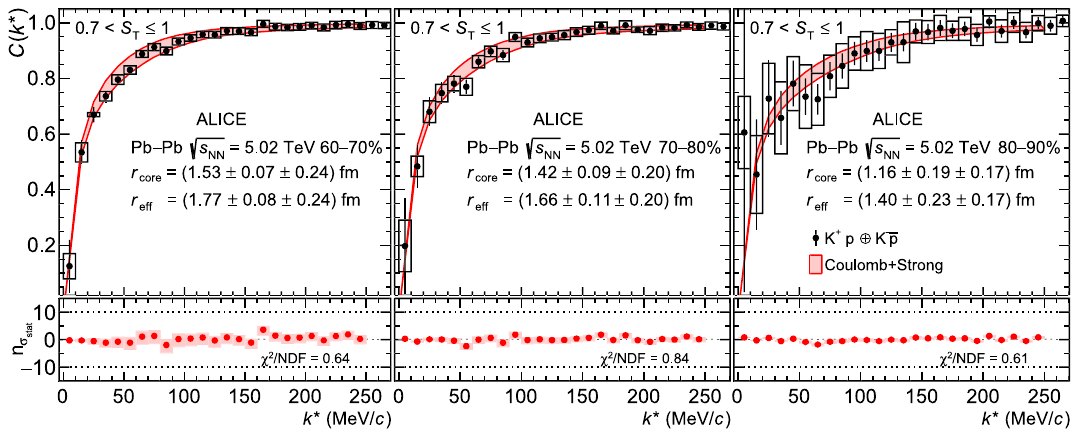
Fig. 3 K + p (K + p ⊕ K − p) correlation functions obtained in Pb–Pb √ s NN = 5 . 02 TeV in the 60–70% (left), 70–80% (mid- collisions at dle) and 80–90% (right) centrality intervals. The measurement is shown by the black markers. The vertical error bars and the boxes represent the statistical and systematic uncertainties, respectively. The red band